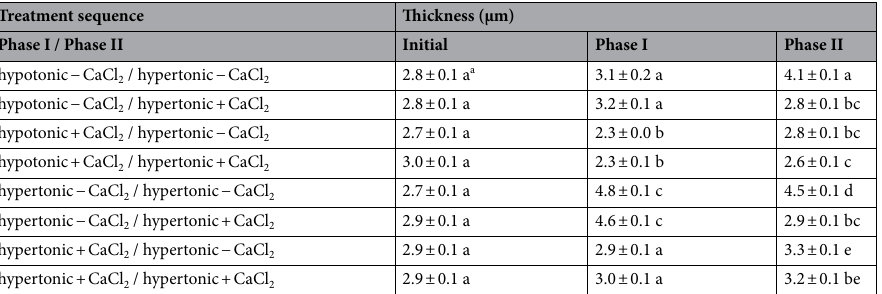
Table 5. Effects of CaCl 2 and cell turgor on thickness of anticlinal epidermal cell walls of excised skin segments (ES) of ʻ Burlat ʼ sweet cherry fruit. Cell turgor was manipulated by incubating ES in 0.25 M sucrose (hypotonic) or 1.5 M sucrose (hypertonic) in the presence of 10 mM CaCl 2 (‘ + CaCl 2 ’) or its absence (‘− CaCl 2 ’). The experiment was conducted by imposing sequential treatments on the same specimens. First, initial thickness of cell walls was measured (‘initial’). The experiment then continued with two phases lasting 24 h each. All solutions were buffered using 10 mM MES at pH 5.8. At the end of each phase, cell wall thickness was measured. Data are means ± SE. a Mean separation within columns, Tukey’s Studentized range test at p < 0.05.